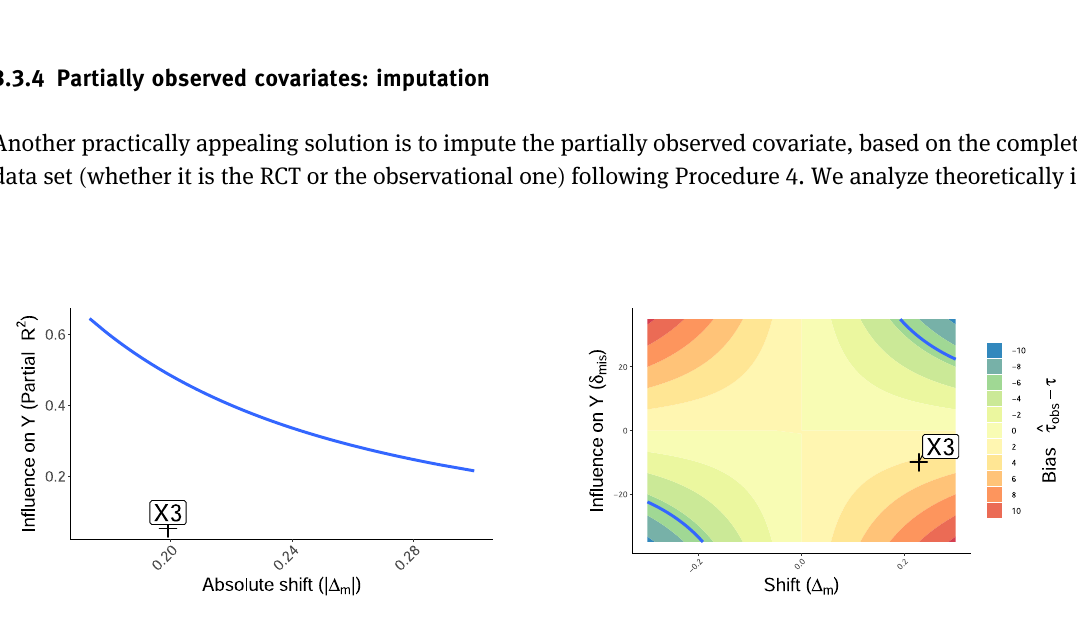
Figure 2: Sensitivity maps: X 3 is supposed to be a missing covariate. ( Left ) Regular sensitivity map showing how strong an key covariate would need to be to induce a bias of ~6 in function of the two sensitivity parameters Δ m and partial R 2 when a covariate is totally unobserved. ( Right ) The exact same simulation data are represented, while using rather δ mis than the partial R 2 , and superimposing the heatmap of the bias which allows to reveal the general landscape along with the sign of the